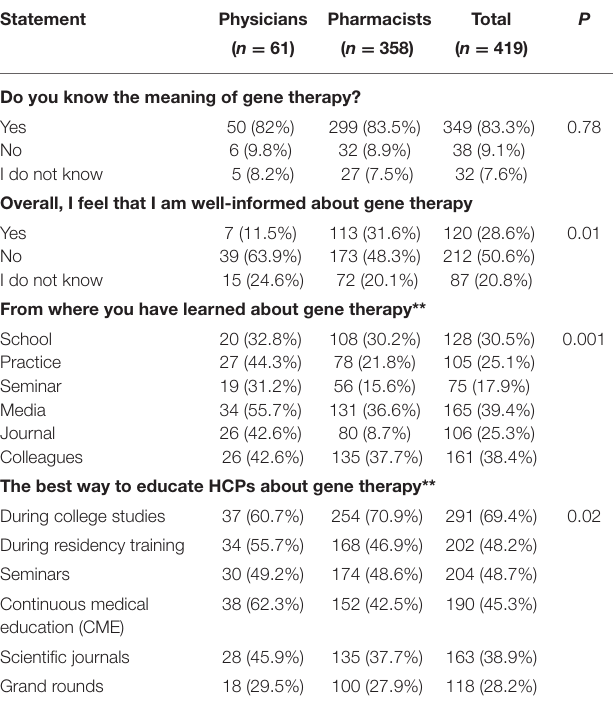
TABLE 3 | Self-assessed knowledge and suggested approaches to educate gene therapy.